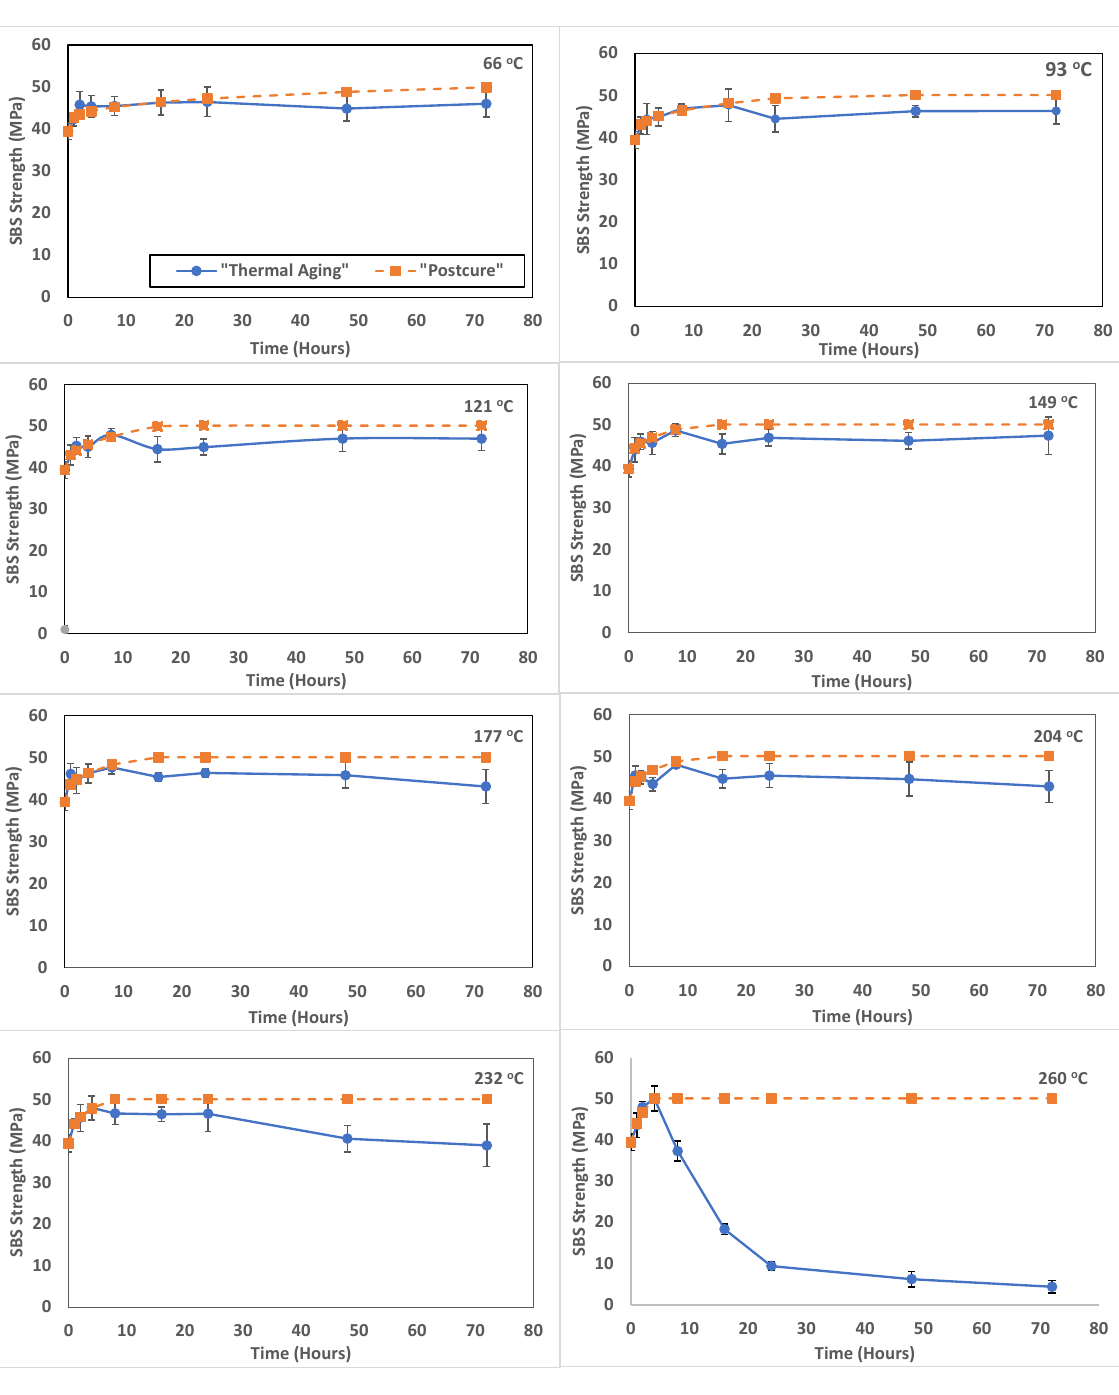
Figure 8. Comparison of effects of thermal aging with predicted postcure levels as a function of time and temperature of aging.